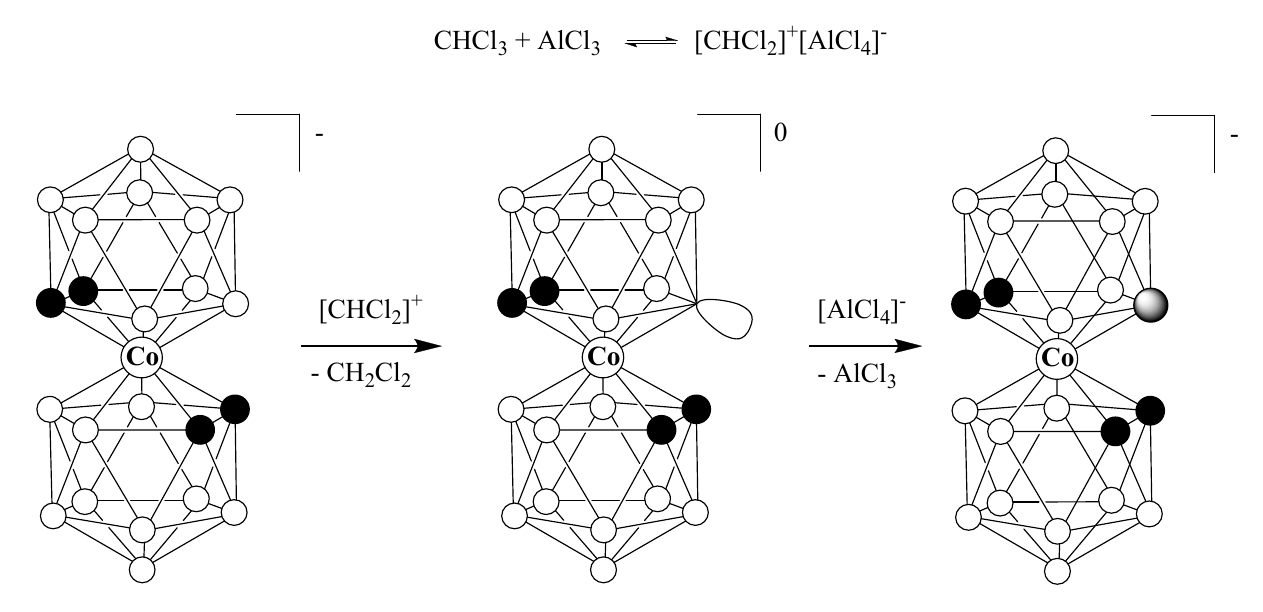
Figure 2. Proposed mechanism of the chlorination of the cobalt bis(dicarbollide) anion by AlCl 3 in chloroform.